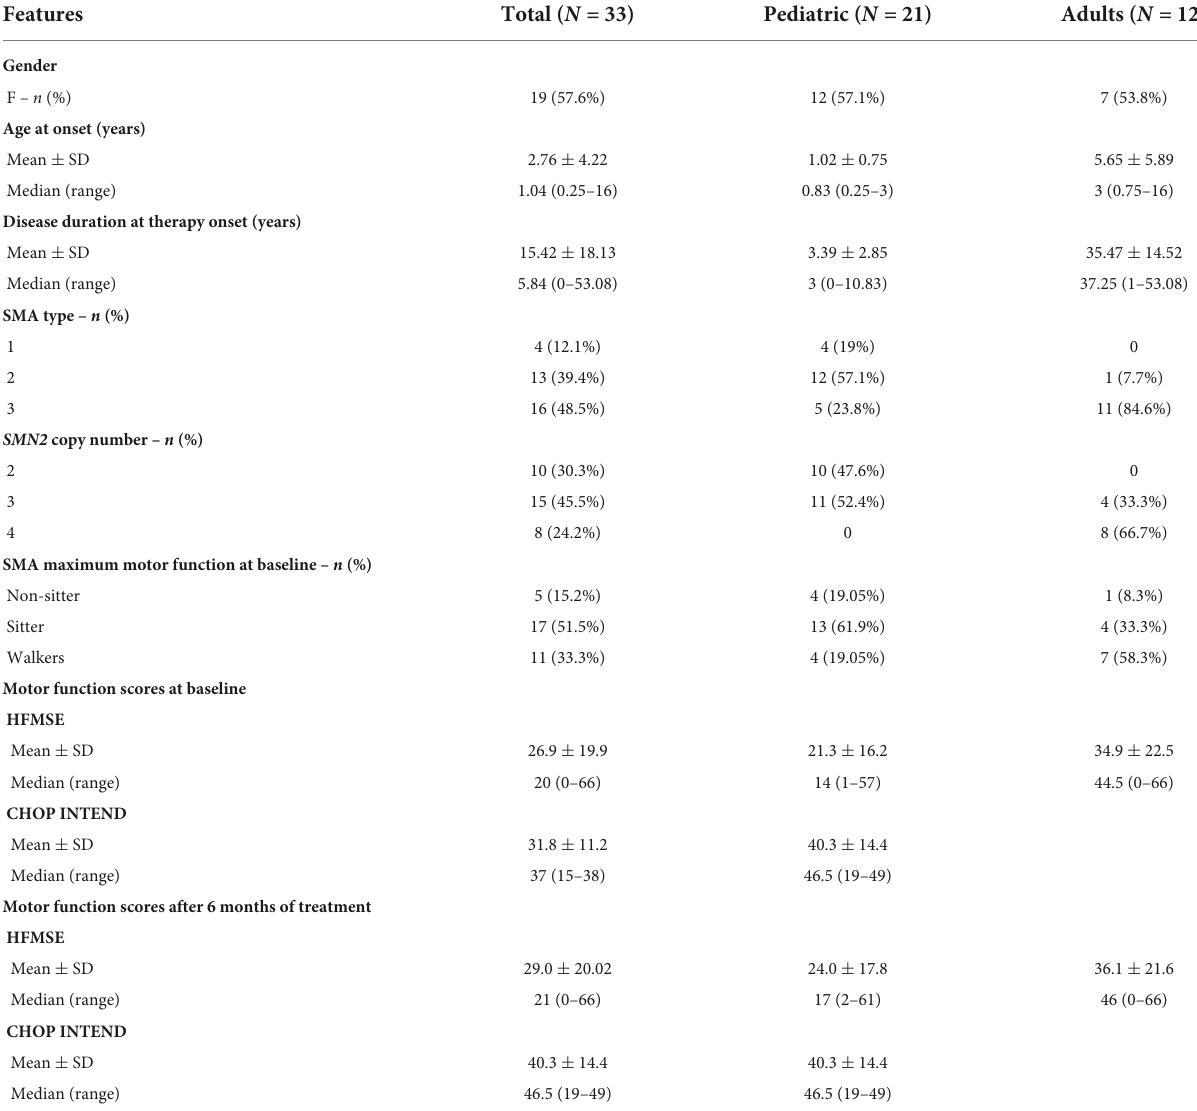
TABLE 1 Characteristics of the spinal muscular atrophy (SMA) patients participating in the